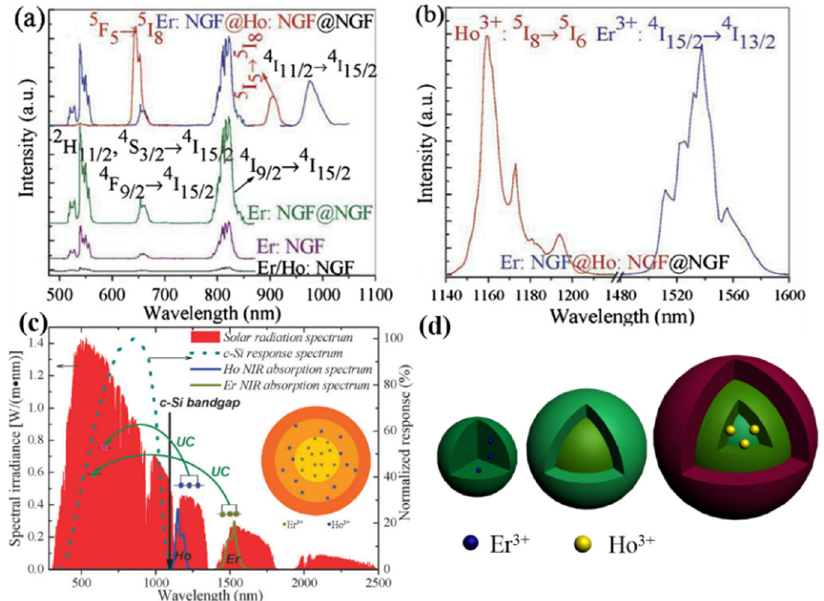
Figure 8. ( a ) Upconversion emission spectra of the core NaGdF 4 :Er 3+ /Ho 3+ nanocrystals, the core NaGdF 4 :Er 3+ nanocrystals, the core/shell NaGdF 4 :Er 3+ @NaGdF 4 nanocrystals, and the NaGdF 4 :Er 3+ @NaGdF 4 :Ho 3+ @NaGdF 4 core/shell/shell nanocrystals; ( b ) Upconversion excitation spectrum of the NaGdF 4 :Er 3+ @NaGdF 4 :Ho 3+ @NaGdF 4 core/shell/shell nanocrystals; ( c ) A schematic illustration of the upconversion luminescence of NaGdF 4 :Er 3+ @NaGdF 4 :Ho 3+ @NaGdF 4 nanocrystals versus the bandgap of c-for Si solar cell, and the spectrum of AM 1.5 sun irradiation; ( d ) A schematic of illustration of different nanostructures: the NaGdF 4 :Er 3+ core, the NaGdF 4 :Er 3+ @NaGdF 4 core/shell, and the NaGdF 4 :Er 3+ @NaGdF 4 :Ho 3+ @NaGdF 4 core/shell/shell (adapted with permission from [87]; Copyright Royal Society of Chemistry,